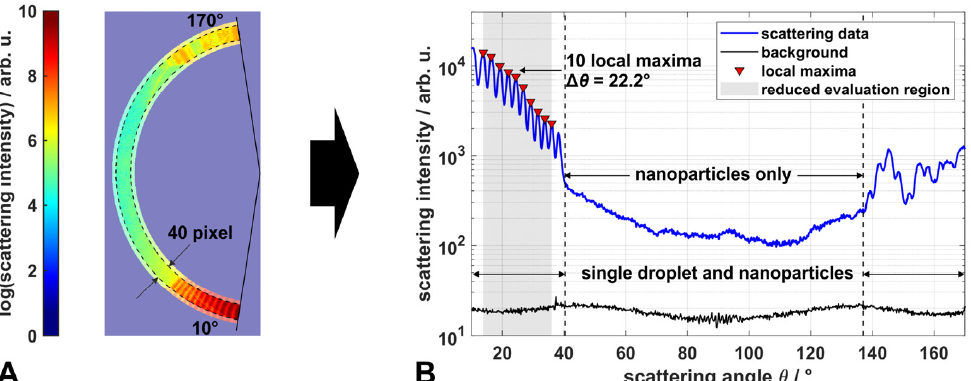
Figure 2. Example determination of the droplet size from superimposed scattering data of TiO 2 - nanoparticles and an EtOH/TTIP droplet: From the scattering image of a mirror section (( A ); data in logarithmic scaling and displayed in false color), scattering data (blue) are generated and local maxima (red) in the evaluation region are determined (( B ); regions with scattering of droplets and/or particles are labeled correspondingly, background level is shown in black). The droplet size is then determined from the linear correlation curve depicted in Figure 1B.